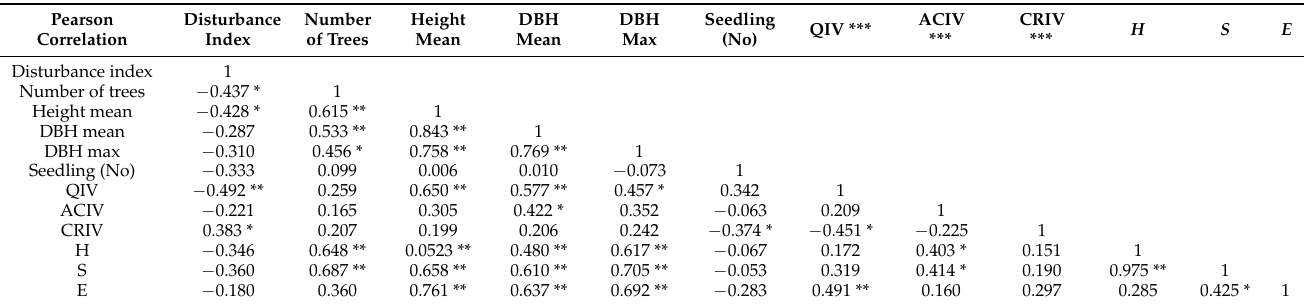
Table 5. Correlation coefficient matrix of the stand structure and composition with the disturbance index of trees (DBH ≥ 5 cm and height ≥ 1.5 m) in a naturally-regenerated broadleaf forest in the Arasbaran biosphere reserve in Iran ( n = 30). Equations for variables are listed in Table 1. The Disturbance Index incorporated levels of observed human impact (few too many signs of cutting and grazing livestock) (see methods).